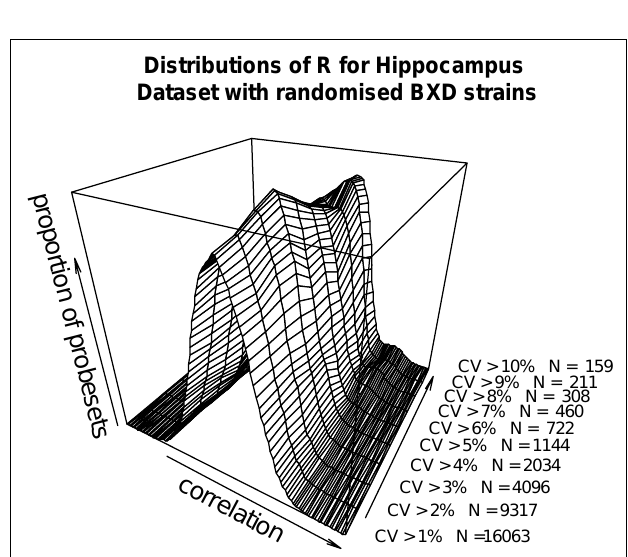
FIGURE 2 | Distribution of correlation coeffi cients for the entire dataset (17203 probesets) and for subsets with CV > 0.01, CV > 0.02 … CV > 0.10 in the hippocampus dataset.